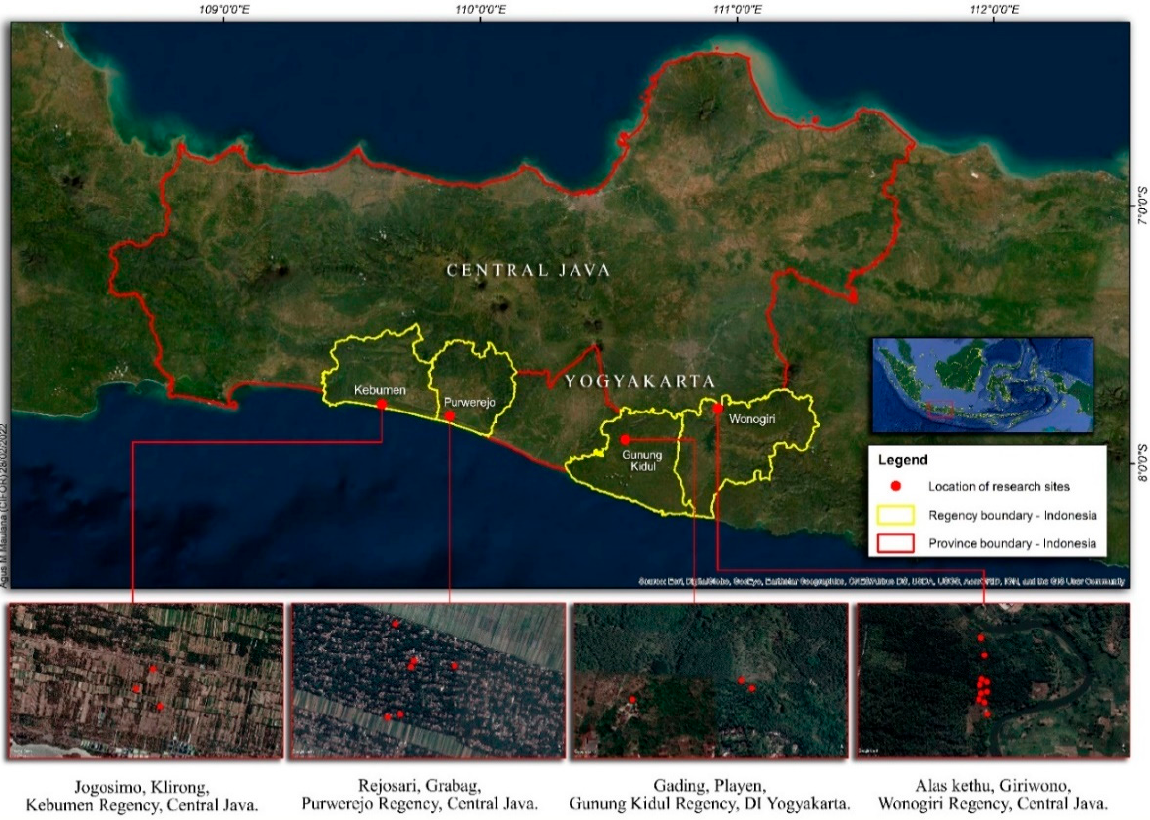
Figure 1. Map of the study areas in Central Java and Daerah Istimewa Yogyakarta, Indonesia.